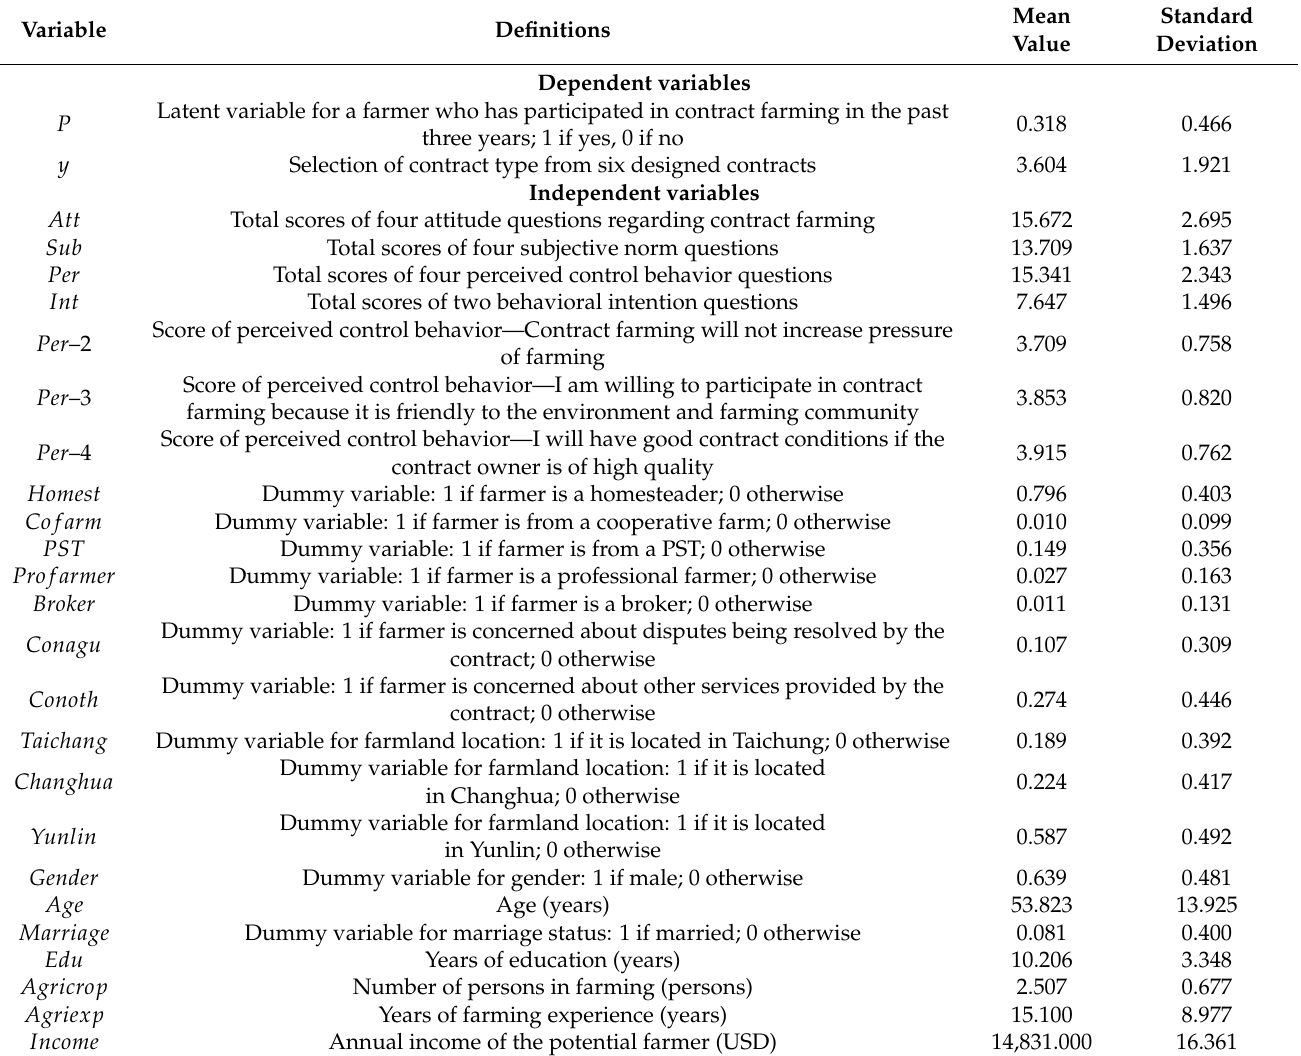
Table 2. Variables used in the estimation and their definitions and mean